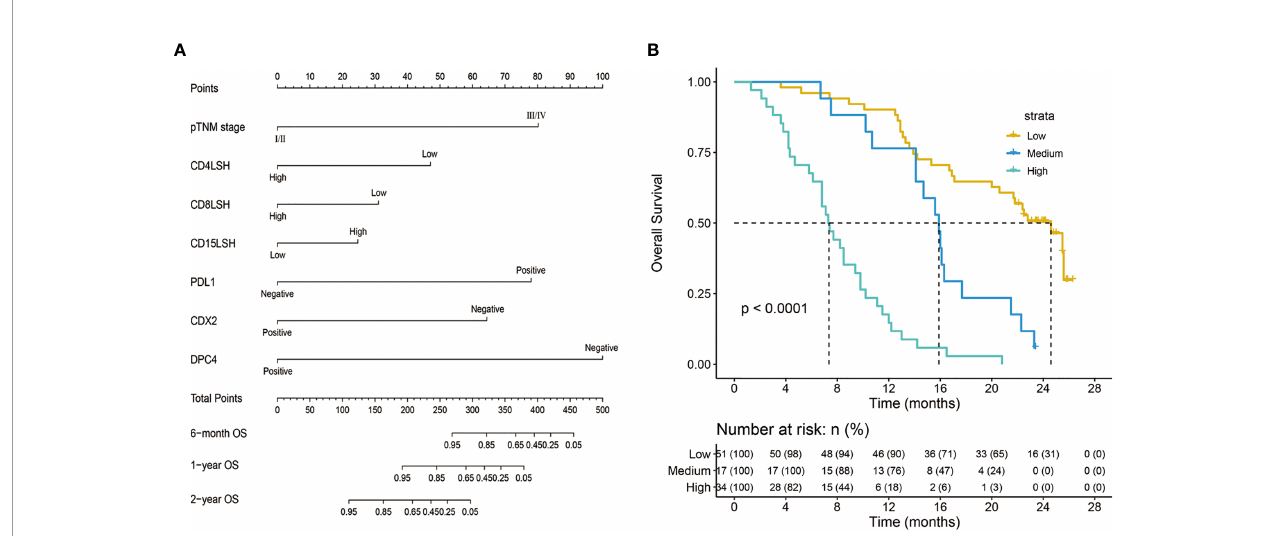
FIGURE 4 | Nomogram predicting the survival rates of PDAC patients at 6 months, 1 year, and 2 years after surgery (A) and a survival curve of individual risk strati fi cation based on the nomogram (B) . pTNM-pathology tumor-node-metastasis; CD4LSH, CD4 expression in large-section histopathology; CD8LSH - CD8 expression in large-section histopathology; CD15LSH, CD15 expression in large-section histopathology; PDL1, programmed cell death-ligand 1; CDX2, caudal-type homeobox 2; DPC4, deleted in pancreatic carcinoma